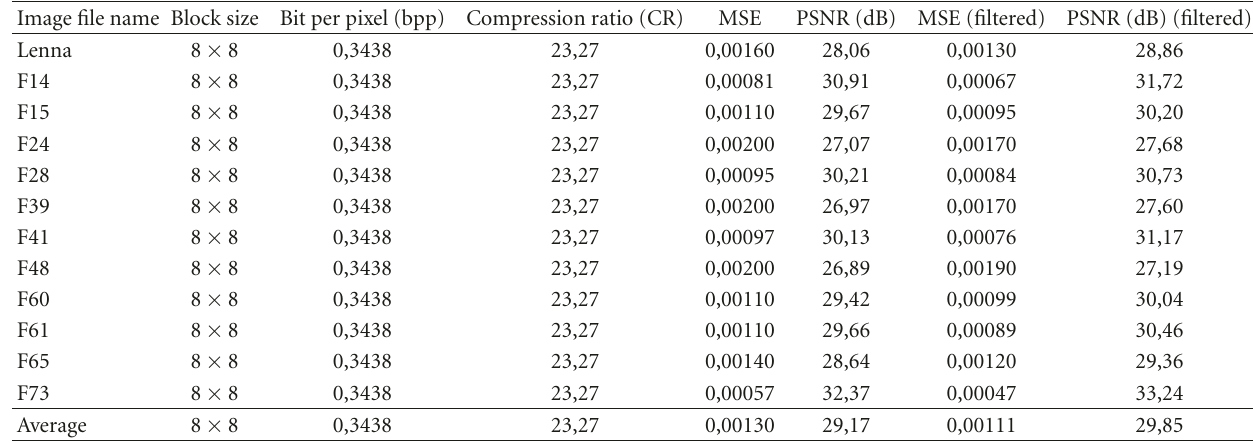
Table 7: Evaluation results of Fold 2 (with clustering).